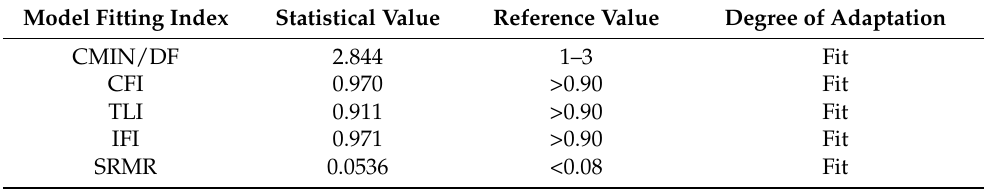
Table 2. Modified model fitness metrics for assessing the degree of adaptation for each